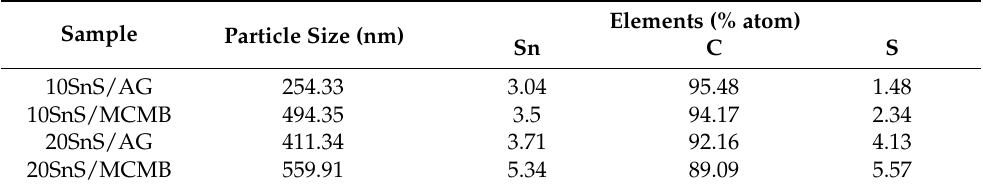
Table 1. FESEM–electron dispersive spectroscopy (EDS) analysis conducted before cycling to de- termine the content and particle size of Sn and S.